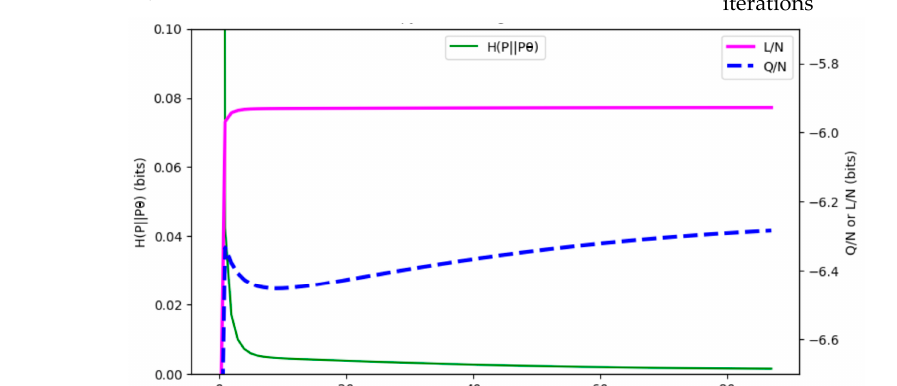
Table 5. The iteration numbers and final parameters for different algorithms.